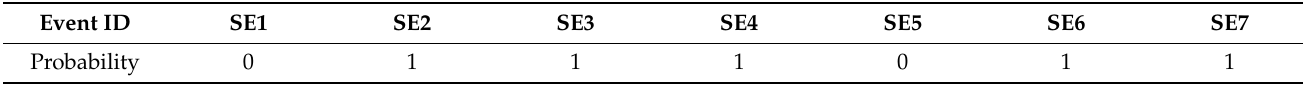
Table 13. Source events setting for the Nanjing COVID-19